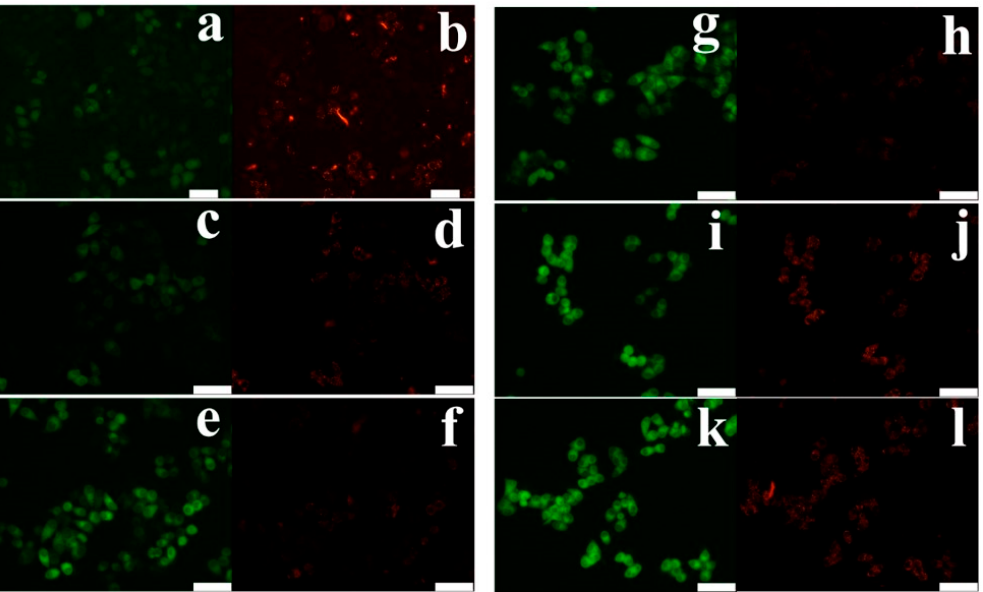
Figure 5. Pcar and Das combined therapy induces mitochondrial membrane depolarization in HepG2 cells. Fluorescence microscopy images show that in JC-1 dye staining, combination treatment groups show increased green fluorescence indicating the reduction in membrane potential. ( a , b ) Control; ( c , d ) 100 µM Pcar; ( e – h ) 10 and 20 µM Das; ( i – l ) 100 µM Pcar + 10 and 20 µM Das.